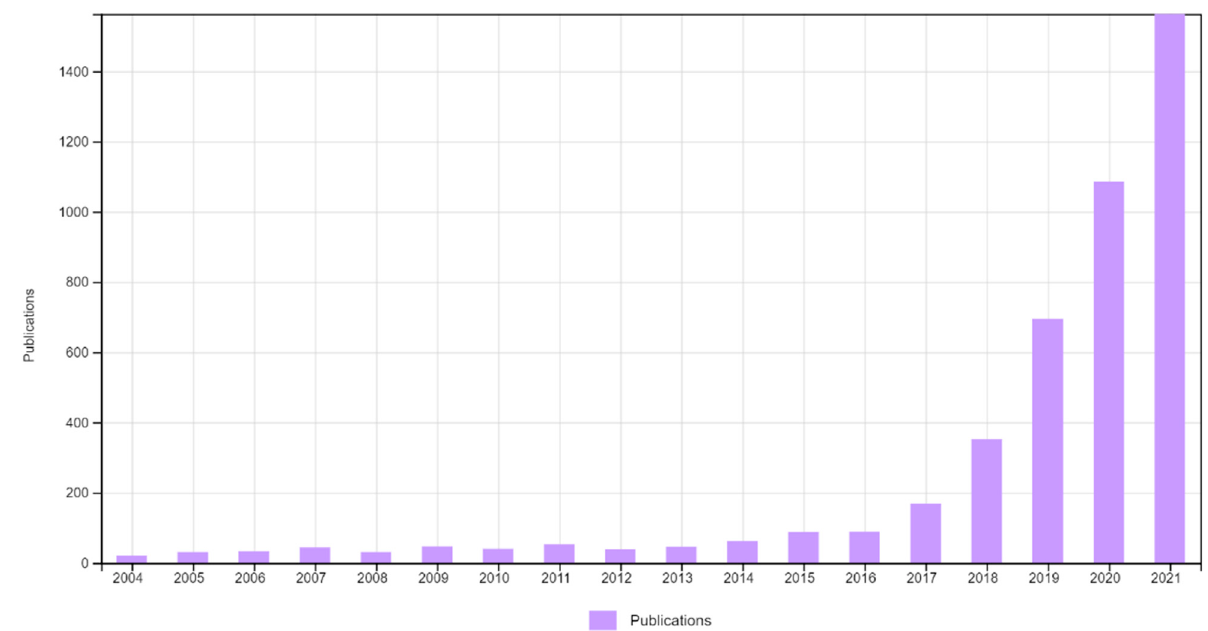
Figure 1. The number of published results about digital twins in the Web of Science.